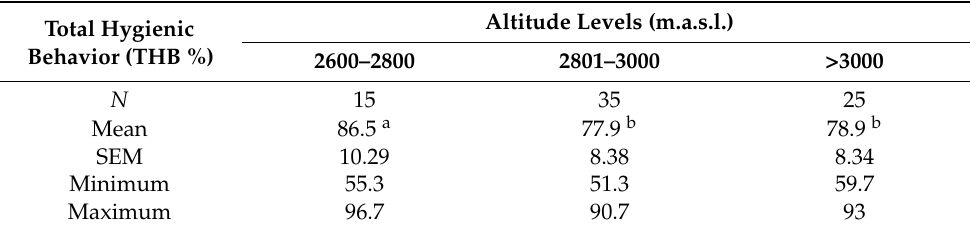
Table 2. Evaluation of the average hygienic behavior of Apis mellifera at different altitude levels of the central highlands of Ecuador.